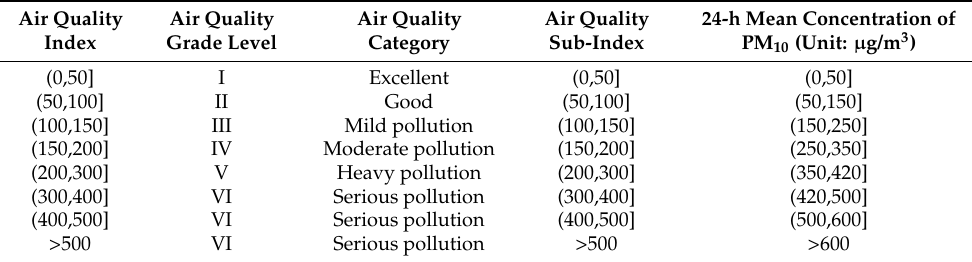
Table 1. PM 10 concentration evaluation